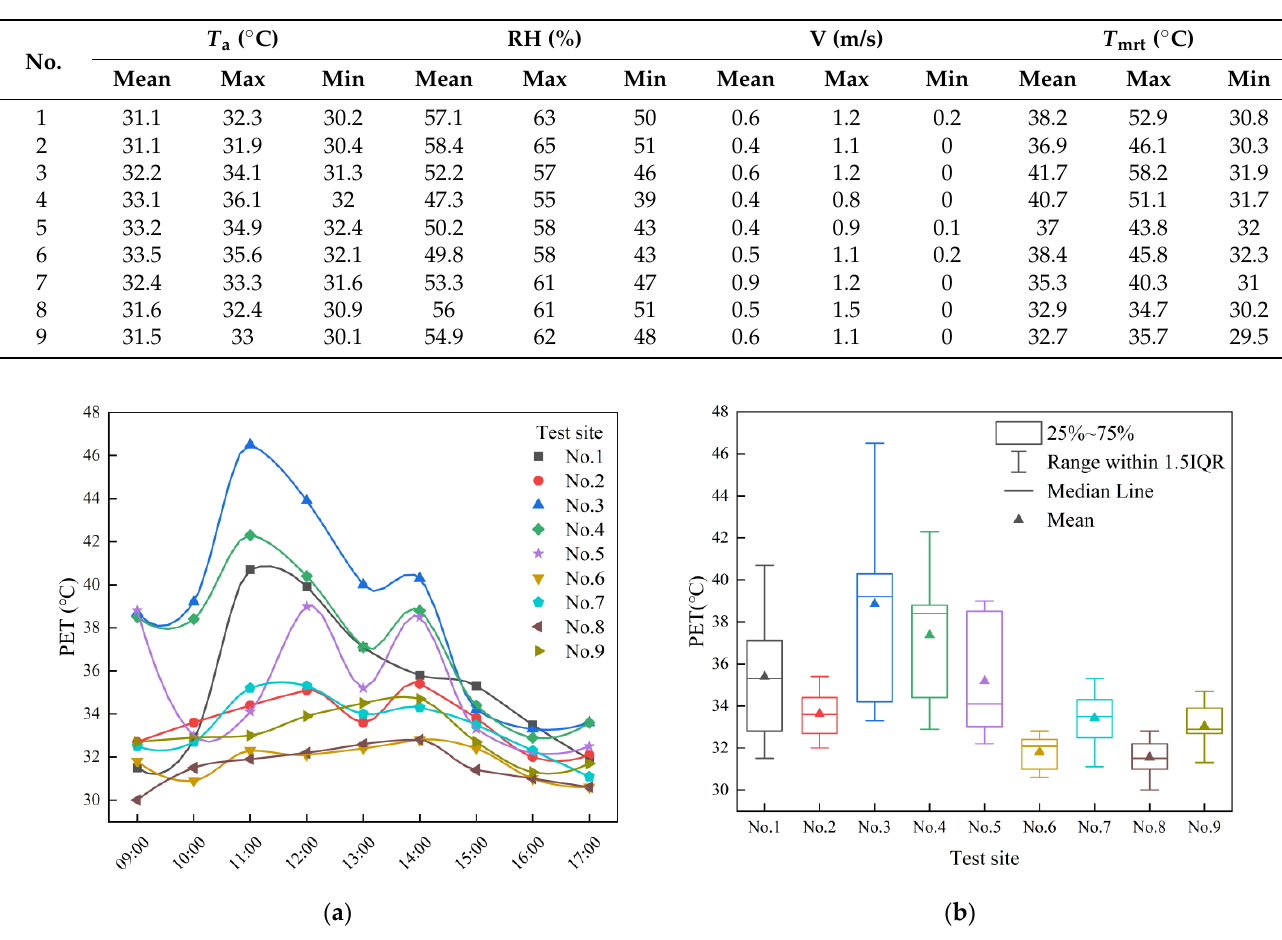
Figure 7. ( a ) Hourly variations of PET at nine test sites. ( b ) PET distributions at nine test sites.